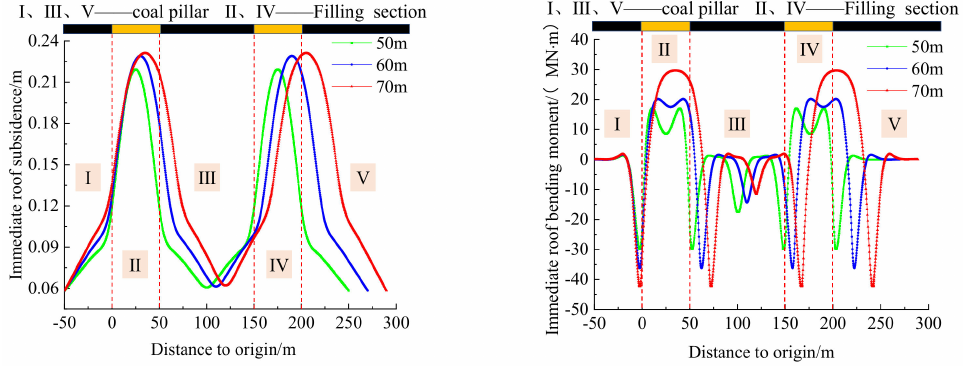
Figure 8. Relationship among the working face lengths, roof subsidence, and bending